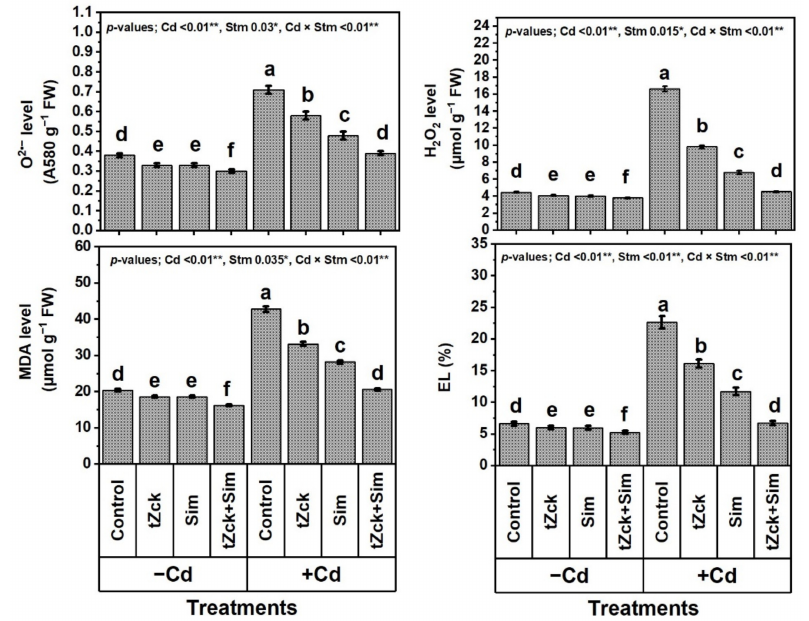
Figure 4. Markers of oxidative stress [superoxide (O 2 •− ) and hydrogen peroxide (H 2 O 2 )] and their consequences [lipid peroxidation as malondialdehyde (MDA) and electrolyte leakage (EL)],